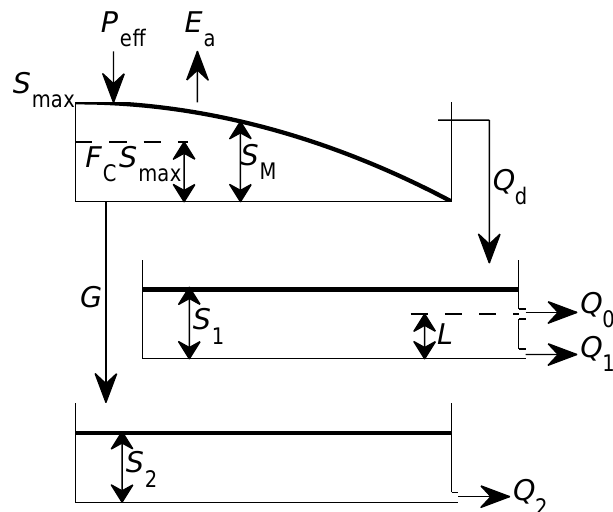
Fig. 1. Model set-up. For meaning of the variables, see Sect.